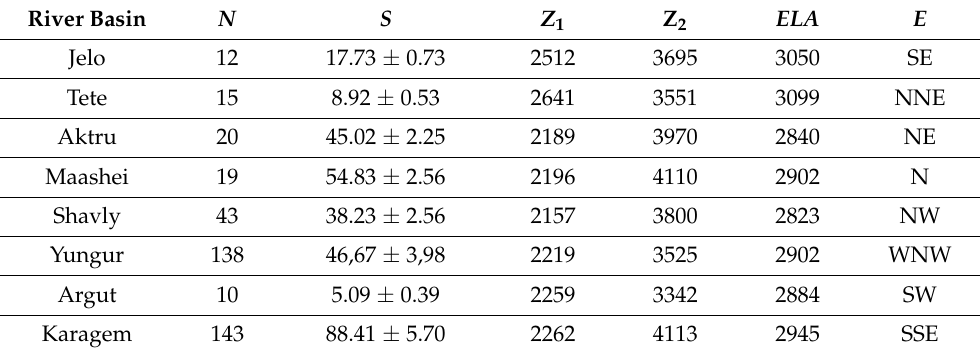
Table 5. LIA glaciers of the North-Chuya ridge. Designations in the table: N—glacier number according to this inventory; S—total areas of the glaciers of the river basin, km 2 ; Z 1 —the altitude of the lowest point of the glaciers, m a.s.l.; Z 2 —the altitude of the upper point of the glacier, m a.s.l.; E—average aspect of the glacier. River Basin N S Z 1